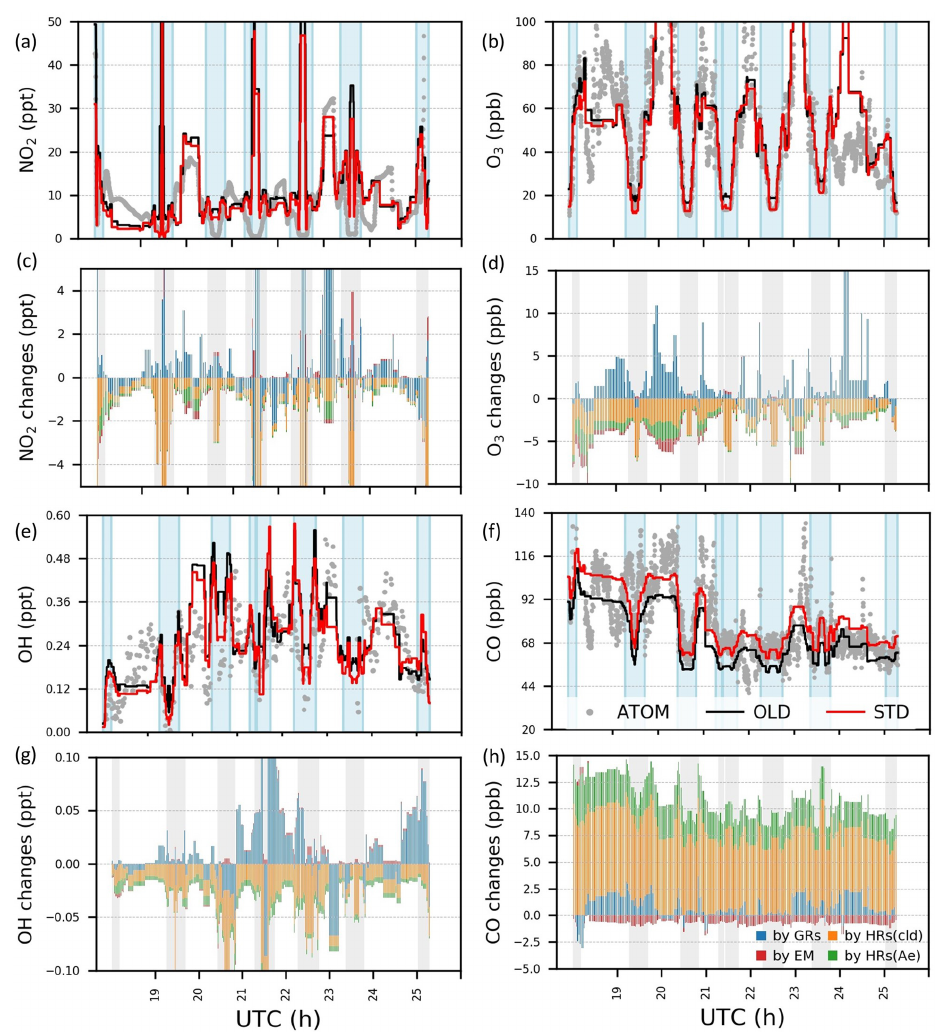
Figure 4. Concentrations and variations by HONO chemistry for NO 2 , O 3 , OH, and CO during ATom-1 flight no. 2 (20–62 ◦ N, 198–210 ◦ E). In panels (a) – (b) and panels (e) – (f) , concentrations by observation (grey dots) and simulations in the OLD case (black lines) and in the STD case (red lines) are plotted. In panels (c) – (d) and panels (g) – (h) , changes in concentrations by GRs (blue bars), EM (red), HRs on clouds (orange), and HRs on aerosols (green) are plotted. Vertical blue and grey columns reflect the data for the regions with air pressure P> 500hPa.